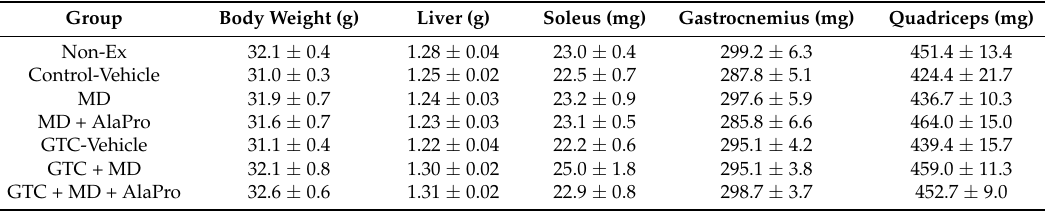
Table 2. Body and tissue